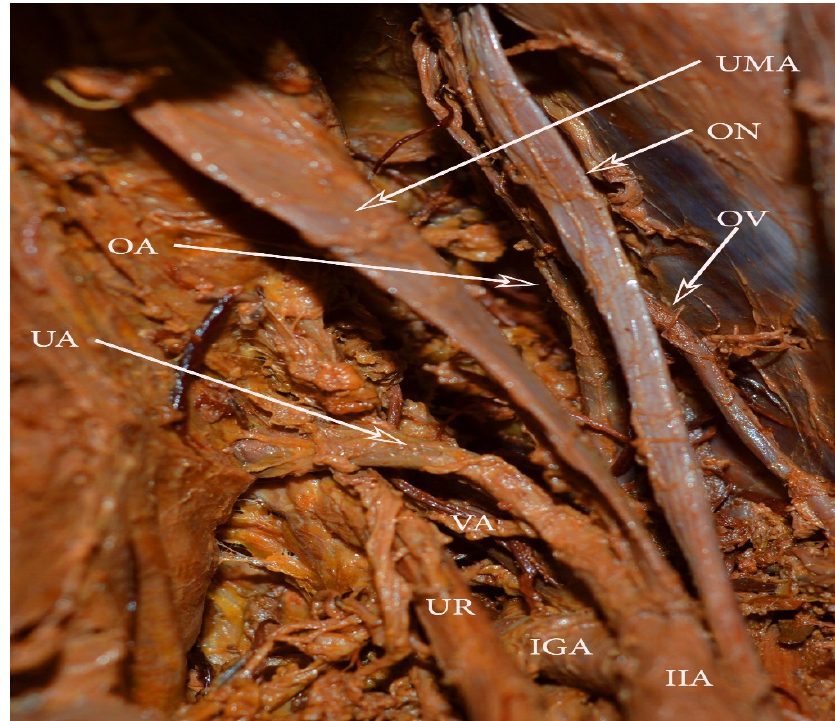
Figure 11. Uterine artery and umbilical artery, arising in a common trunk. VA arising from the uter- ine artery. OA—obturator artery, OV—obturator vein, ON—obturator nerve, UMA—obliterated umbilical artery, IIA—internal iliac artery, IGA—inferior gluteal artery, UR—ureter, VA—vaginal